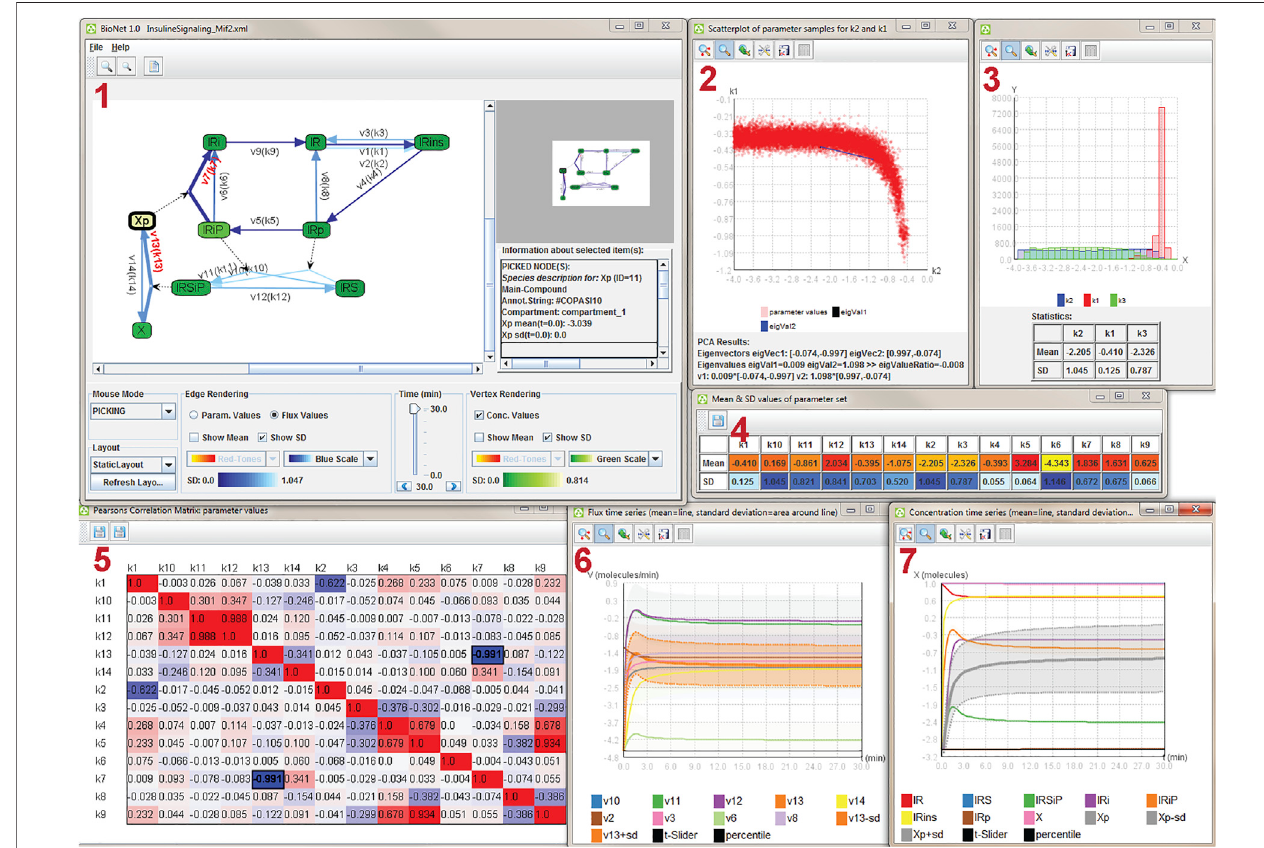
FIGURE 7 | Coordinated multiple views for uncertainty visualization, analyzing an insulin signaling model. Image: © 2012 IEEE. Reprinted, with permission, from Vehlow et al.